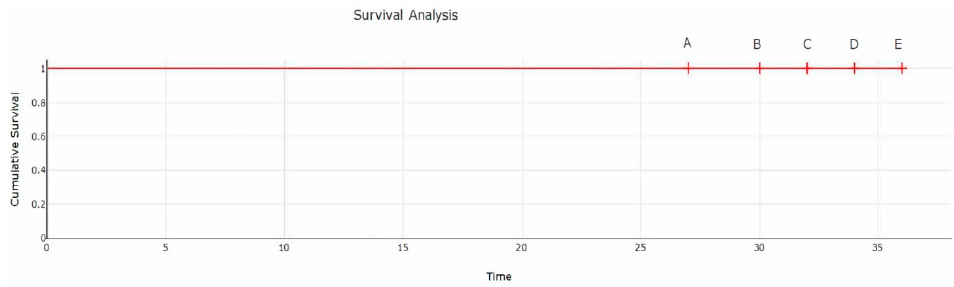
Figure 5. Survival analysis. Four patients (points A, B, C, D; 27, 30, 32, 34 months) had passed away before the final follow-up at 36 months (point E). Points A (27 months), B (30), C (32) and D (34) represent the time points when these patients passed away, and up to that point no implant failure was recorded.